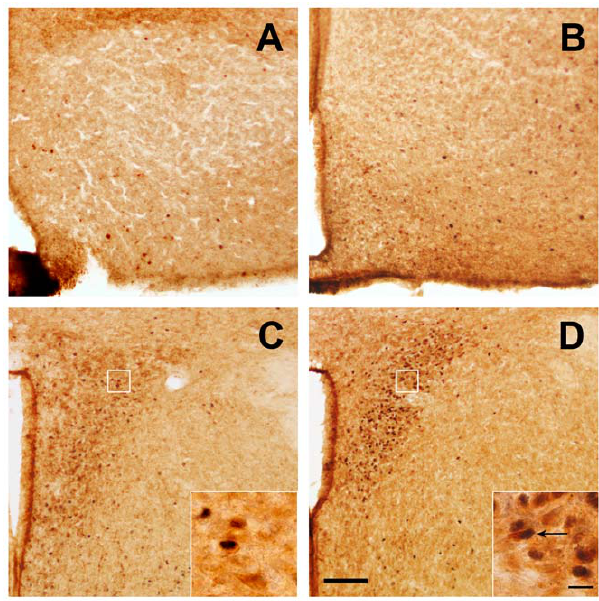
Figure 5. Ghrelin microinjection into the PVN activates CRF neurons. Panels A to B show representative photomicrographs of brains sections subjected to double immunohistochemistry using anti- CRF (brown staining) and anti-c-fos (purple-black staining) antiserum. Upper panels show the ARC and bottom panels show the PVN. Images of panel A and C are from a vehicle-treated mouse and images of panel B and D from a ghrelin-treated mouse. Inserts in C and D panels show high magnification of areas marked in low magnification images. Arrows to dual-labeled cells. Scale bars, 100 m m (low magnification), 10 m m (high